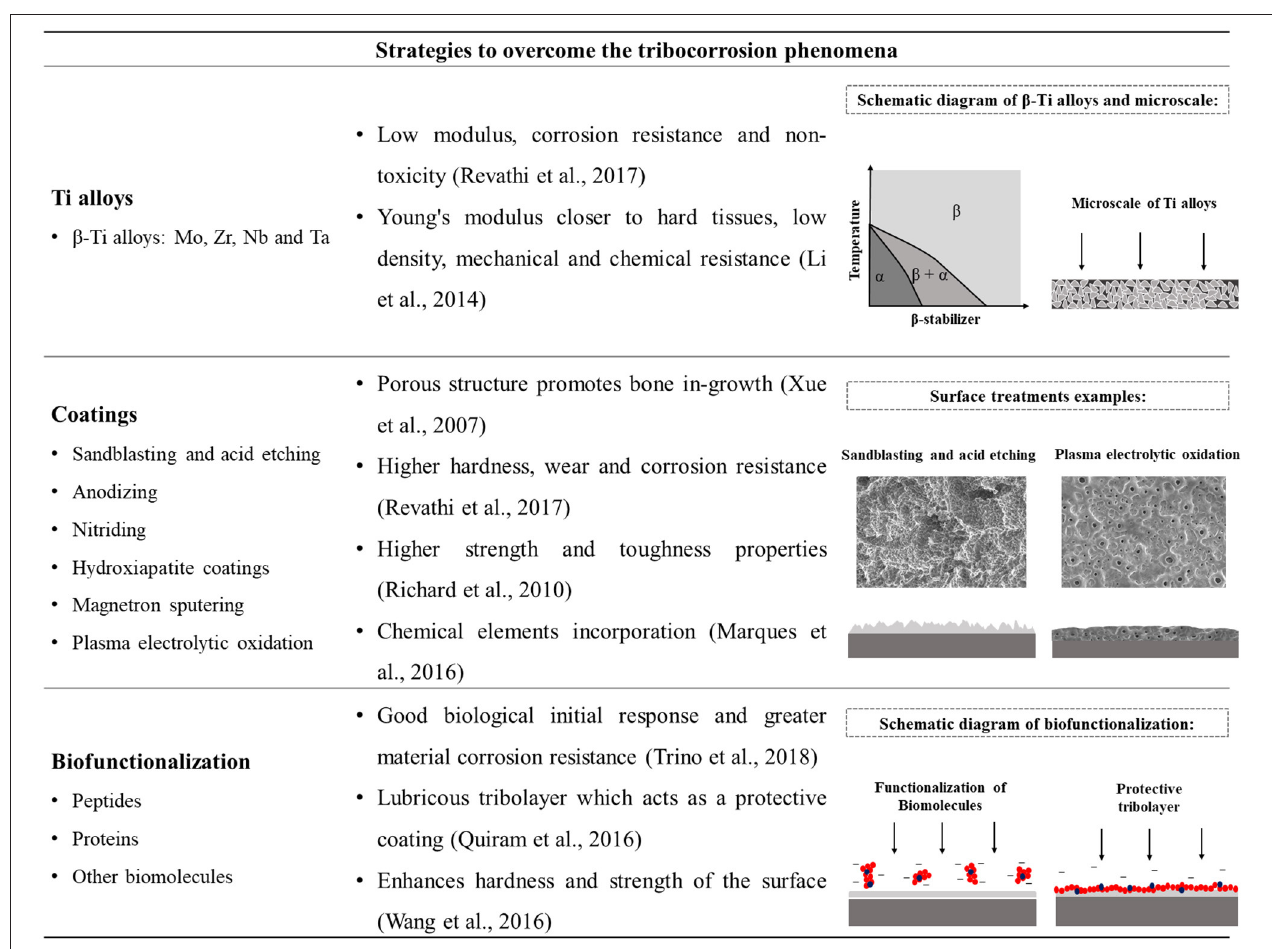
FIGURE 5 | Strategies to overcome the tribocorrosion phenomena with representative imagens of titanium alloys microscale, surface treatments, and biofunctionalization of titanium